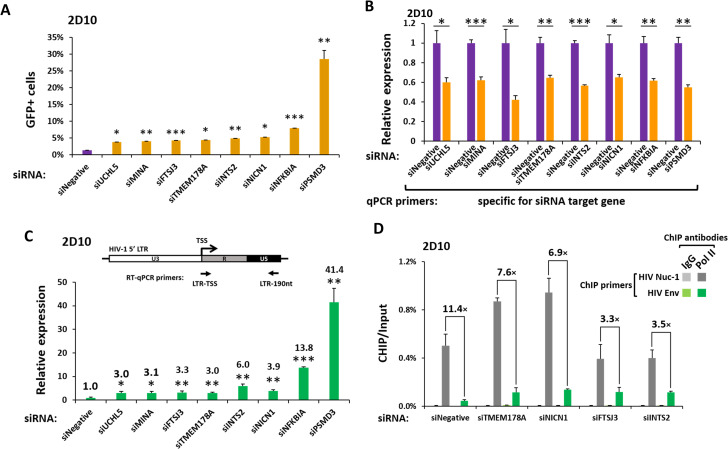
Downregulation of FTSJ3, INTS2, NICN1, and TMEM178A Stimulate Different Stages of RNA Polymerase II Transcription of HIV-1.Jurkat 2D10 cells were nucleofected with either non-targeting siRNA (siNegative) or siRNAs targeting the indicated genes and subjected to: A. Flow cytometry to determine the percentages of GFP+ cells in each population. B. & C. RT-qPCR analyses of the mRNA levels of the genes or region within the HIV provirus that are denoted by their corresponding qPCR primers. All qPCR signals were normalized to those of beta-actin. In panel B, the mRNA levels detected in the CRISPRi− cells were set to 1; in panel C, the mRNA level detected in the siNegative cells was set to 1, and the relative expression level in each group was labeled. D. ChIP-qPCR analyses to determine the levels of RNA polymerase II bound to the proximal HIV LTR or more distant Env region. The ChIP-qPCR signals were normalized to those of input DNA. In all panels, error bars represent mean +/− SD from three experimental replicates. In panels A–C, the asterisks indicate the levels of statistical significance calculated by two-tailed Student’s t-test (*: p<0.05, **: p<0.01, and ***: p<0.001); in panel D, the ratios between the indicated signals are indicated.